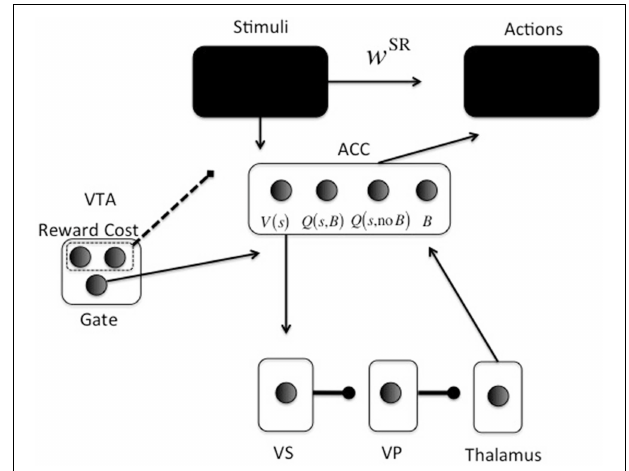
of task difficulty ( c = 0 . 2; low reward = 1; high reward = 2).